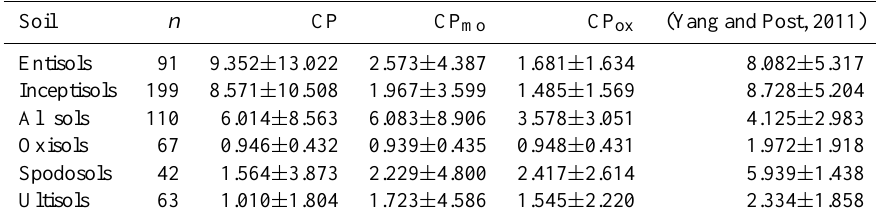
Fig. 2. The simulated P in vegetation (top left), sorbed P (top right), P in soil organic matter and litter (bottom left), and the annual P uptake by vegetation (bottom right) for present day. Table 6. Mean ( ± standard deviation) for simulated labile P (g ( P ) m − 2 ) that typically supports forests compared to measurements (Yang and Post, 2011). The stocks, which are averaged over a 30-yr period (1970–1999), are from simulations with present day soils (CP), uniform low sorption soils (CP mo ), and uniform high sorption soils (CP ox ).